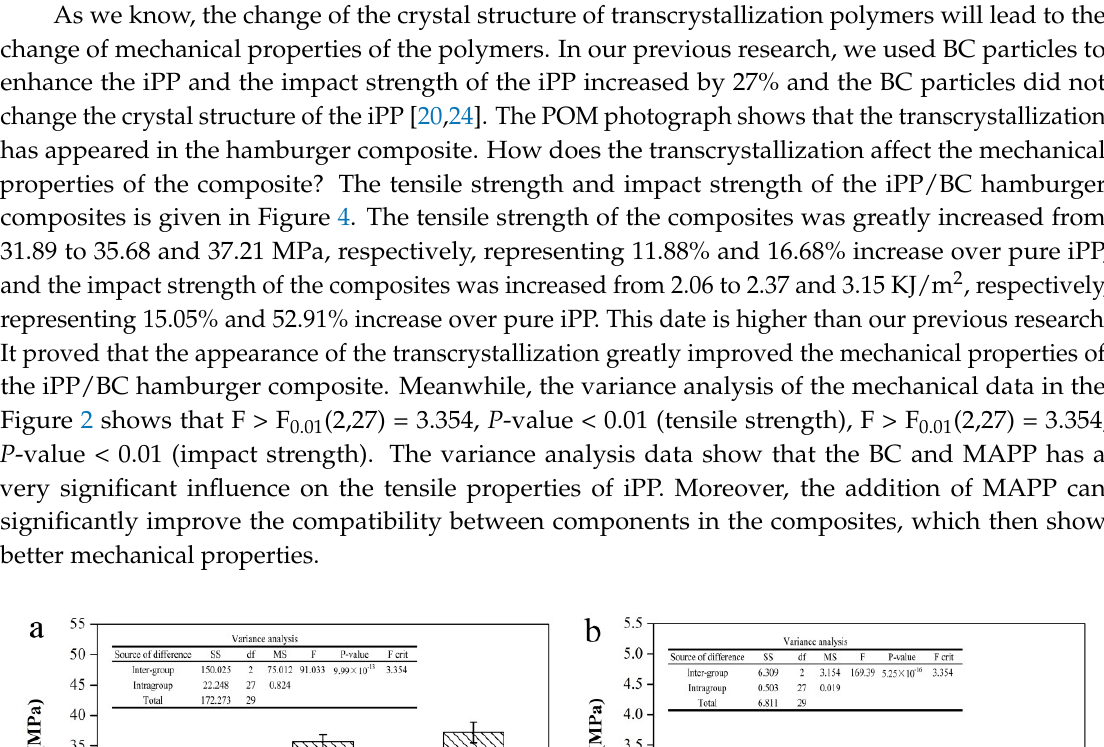
Figure 3. DSC curves of the iPP/BC hamburger composite ( a ) isothermal crystallization curve; ( b ) reheating curve).